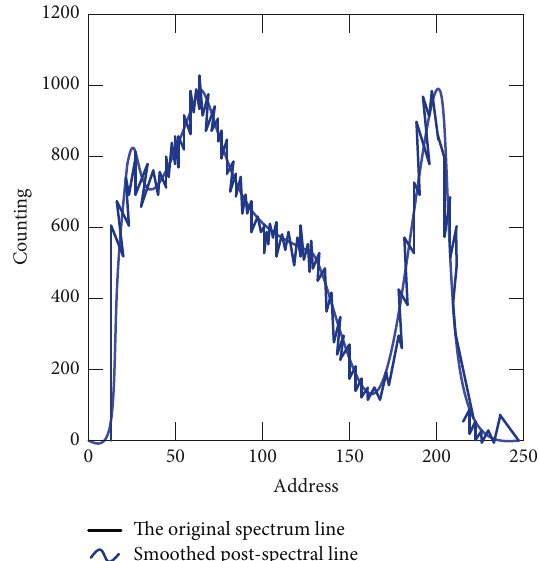
Figure 12: Cs-137 spectrum processed by S – K digital